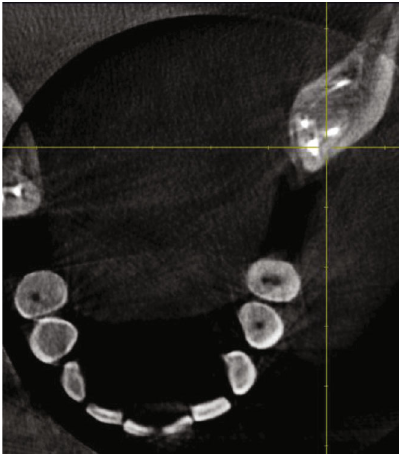
Figure 6: CBCT axial view